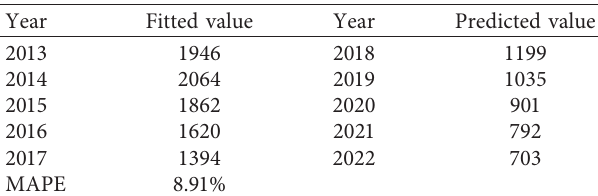
Table 3: The number of losing-market